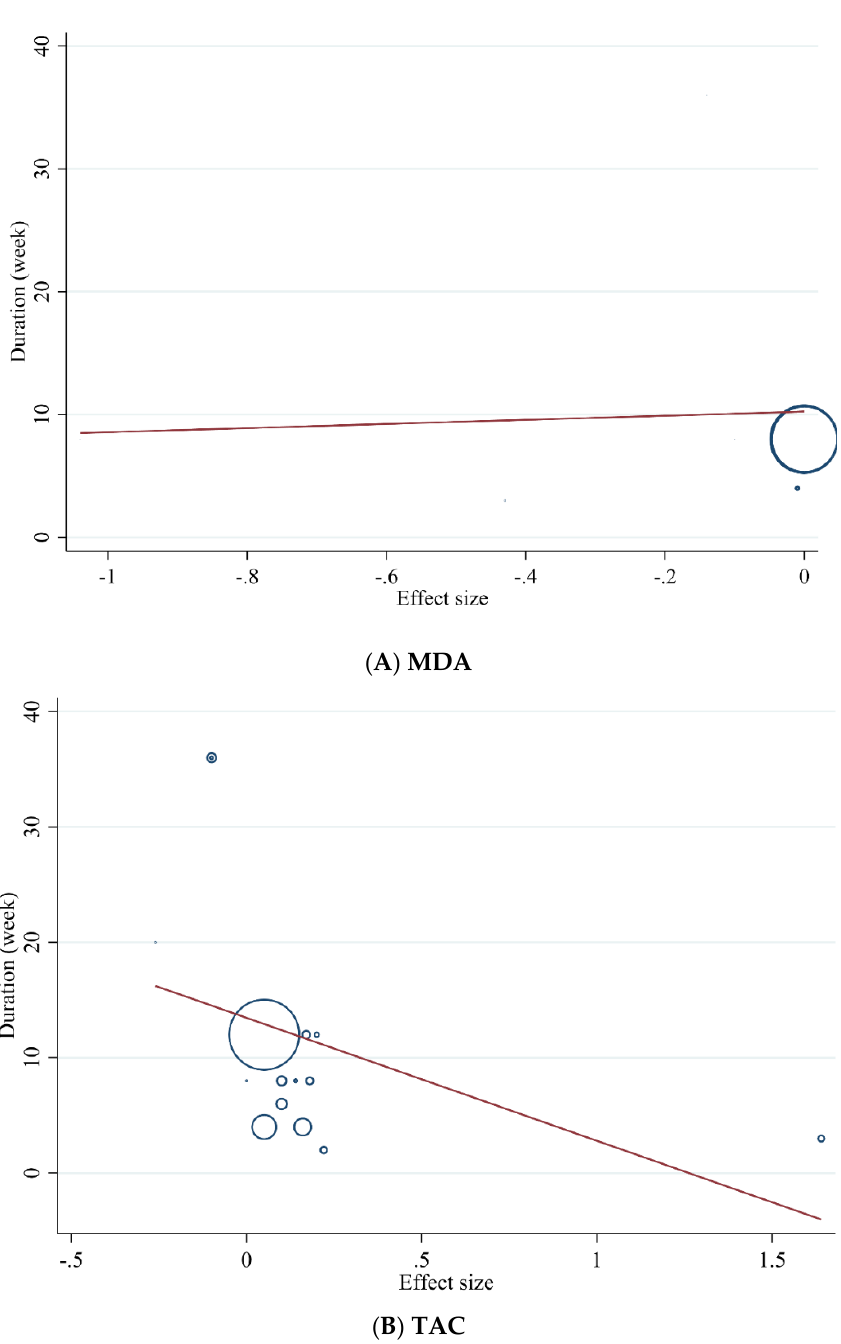
Figure 8. Random-effects meta-regression plots of the association between duration of intervention (weeks) and effect size of ( A ) MDA and ( B ) TAC.